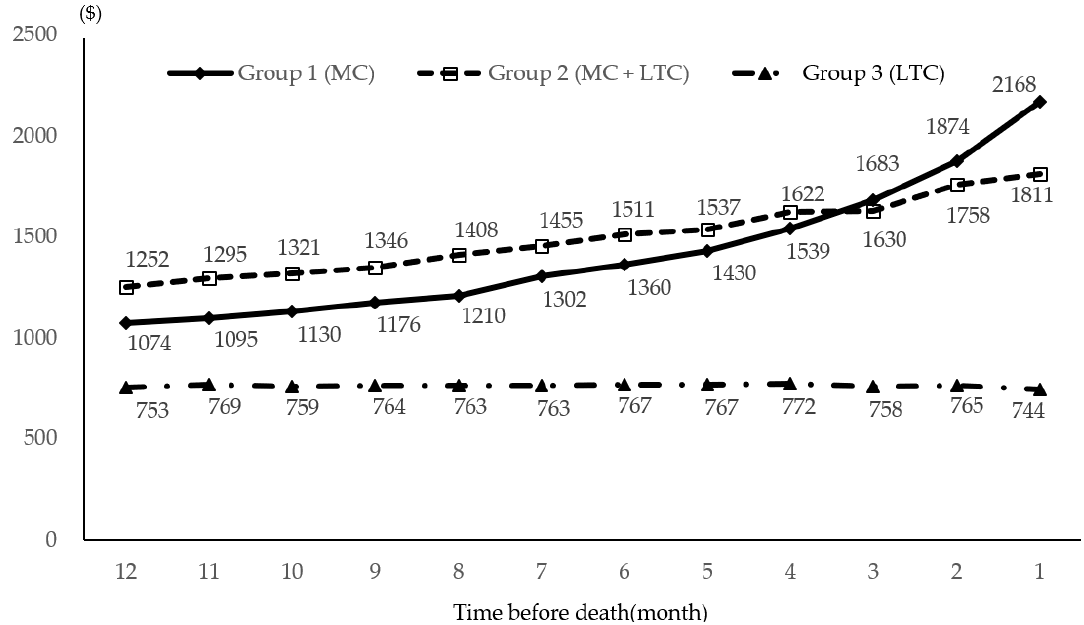
Figure 1. Average medical costs during the last year before death among long-term care beneficiaries. Note: numbers are means; USD 1 = KRW 1130.50.